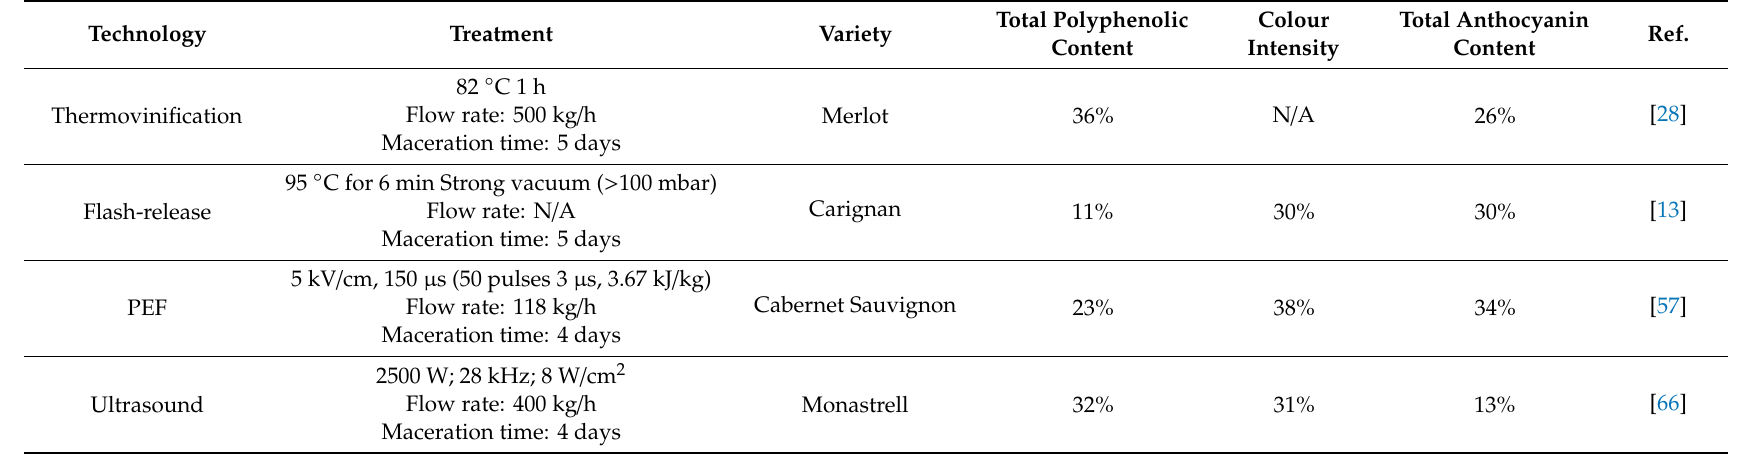
Table 1. Improvements derived of grape treatment before vinification with di ff erent thermal and non-thermal physical methods in terms of increment in total polyphenolic content, color intensity and total anthocyanin